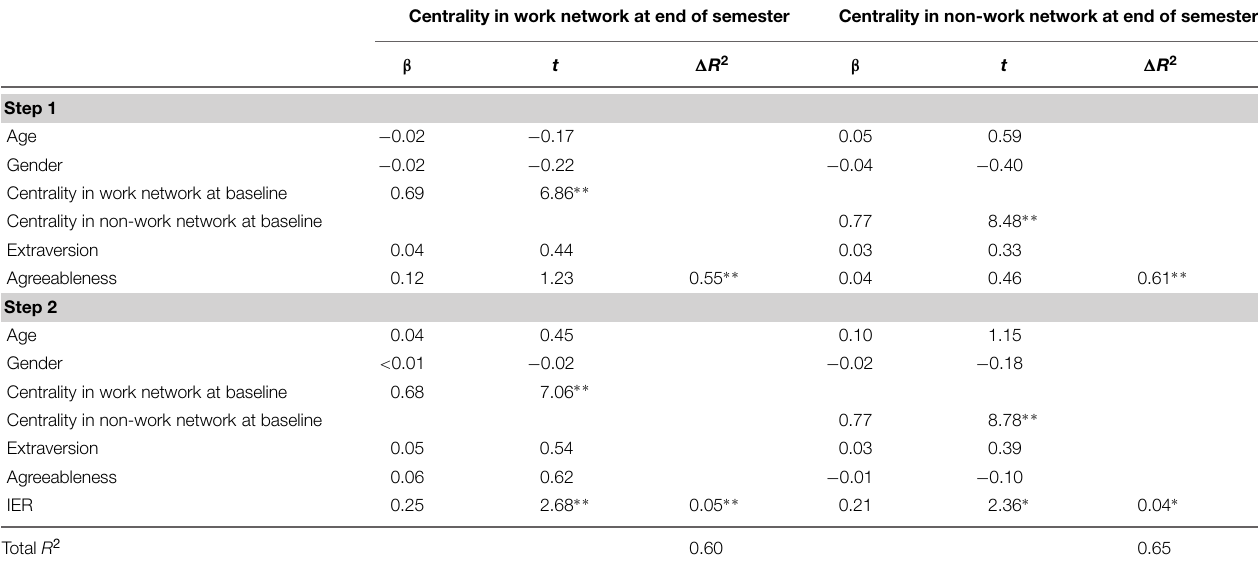
TABLE 2 | Regression analyses predicting change in social network popularity in Study